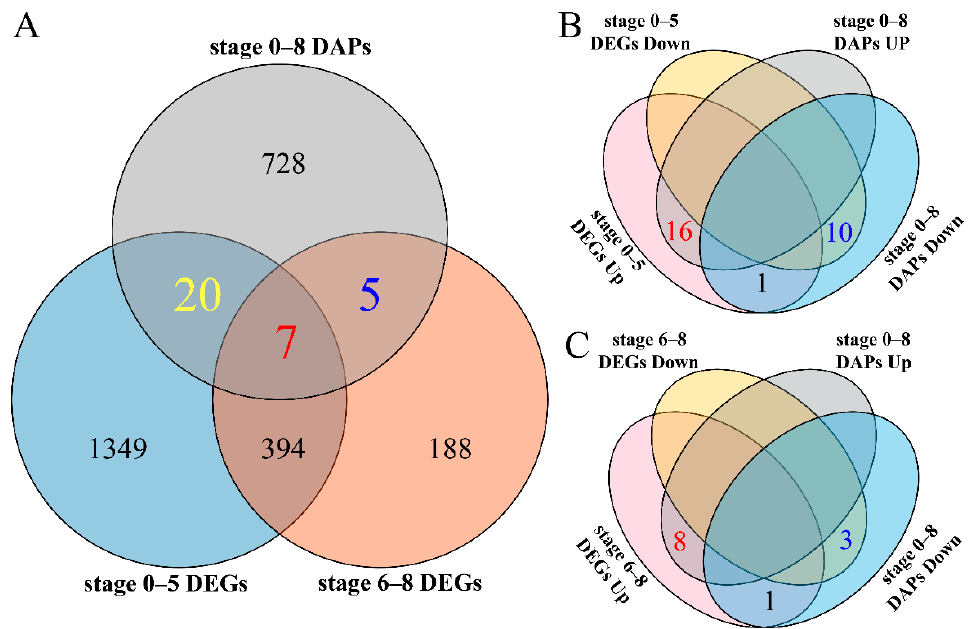
Figure 6. The Venn diagram of proteomic (iTRAQ) and transcriptomic (RNA-seq) analysis for the similarities and differences of DAPs/DEGs. ( A ) Conjoint analysis of proteins and transcripts showing unique and shared DAPs/DEGs. ( B ) and ( C ) up- and downregulated DAPs/DEGs at 0–5 and 6–8 periods in inap CMS, respectively.